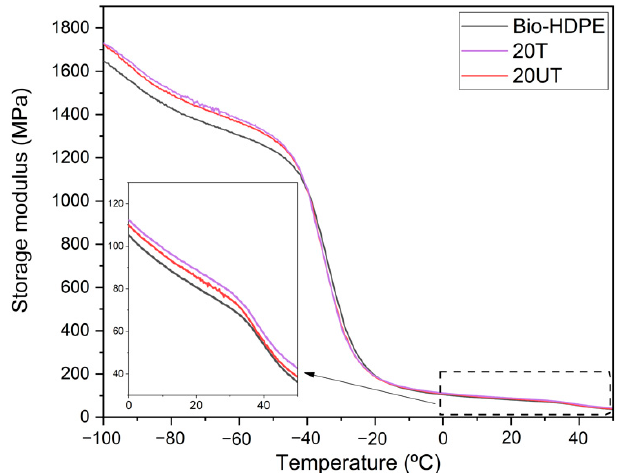
Figure 2. Evolution of storage modulus (G’) of bio-based high-density polyethylene (Bio-HDPE) with 20 wt.% of untreated (20UT) and treated (20T) chia seed flour.